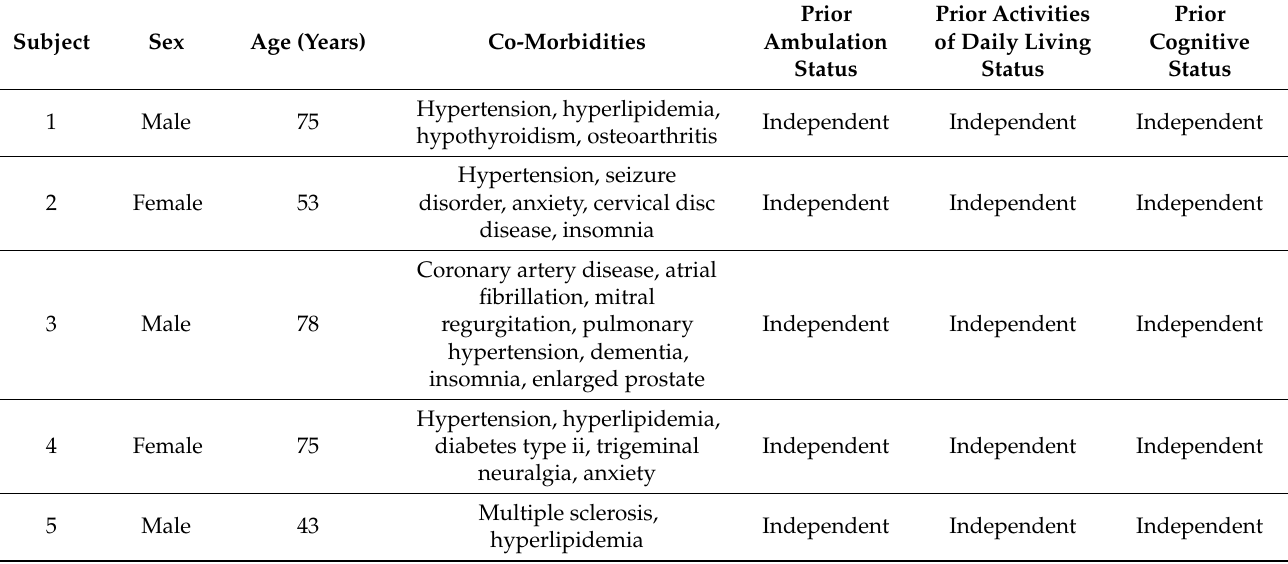
Table 1. Subject demographics, co-morbidities, and prior functional abilities.